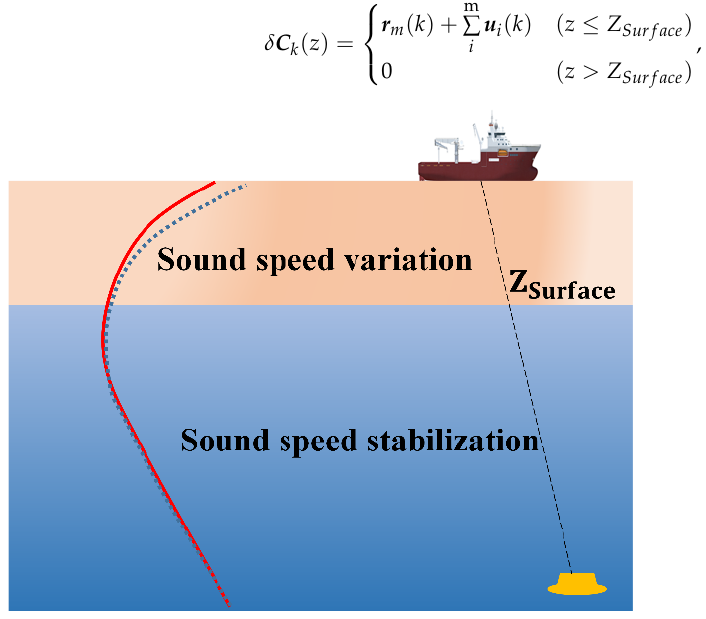
Figure 4. The scheme of sound velocity variation and stabilization. Another important step is to calculate the δ T and SRT method. In this study, the k travel time delay V following SSVD extraction method (Algorithm 1).